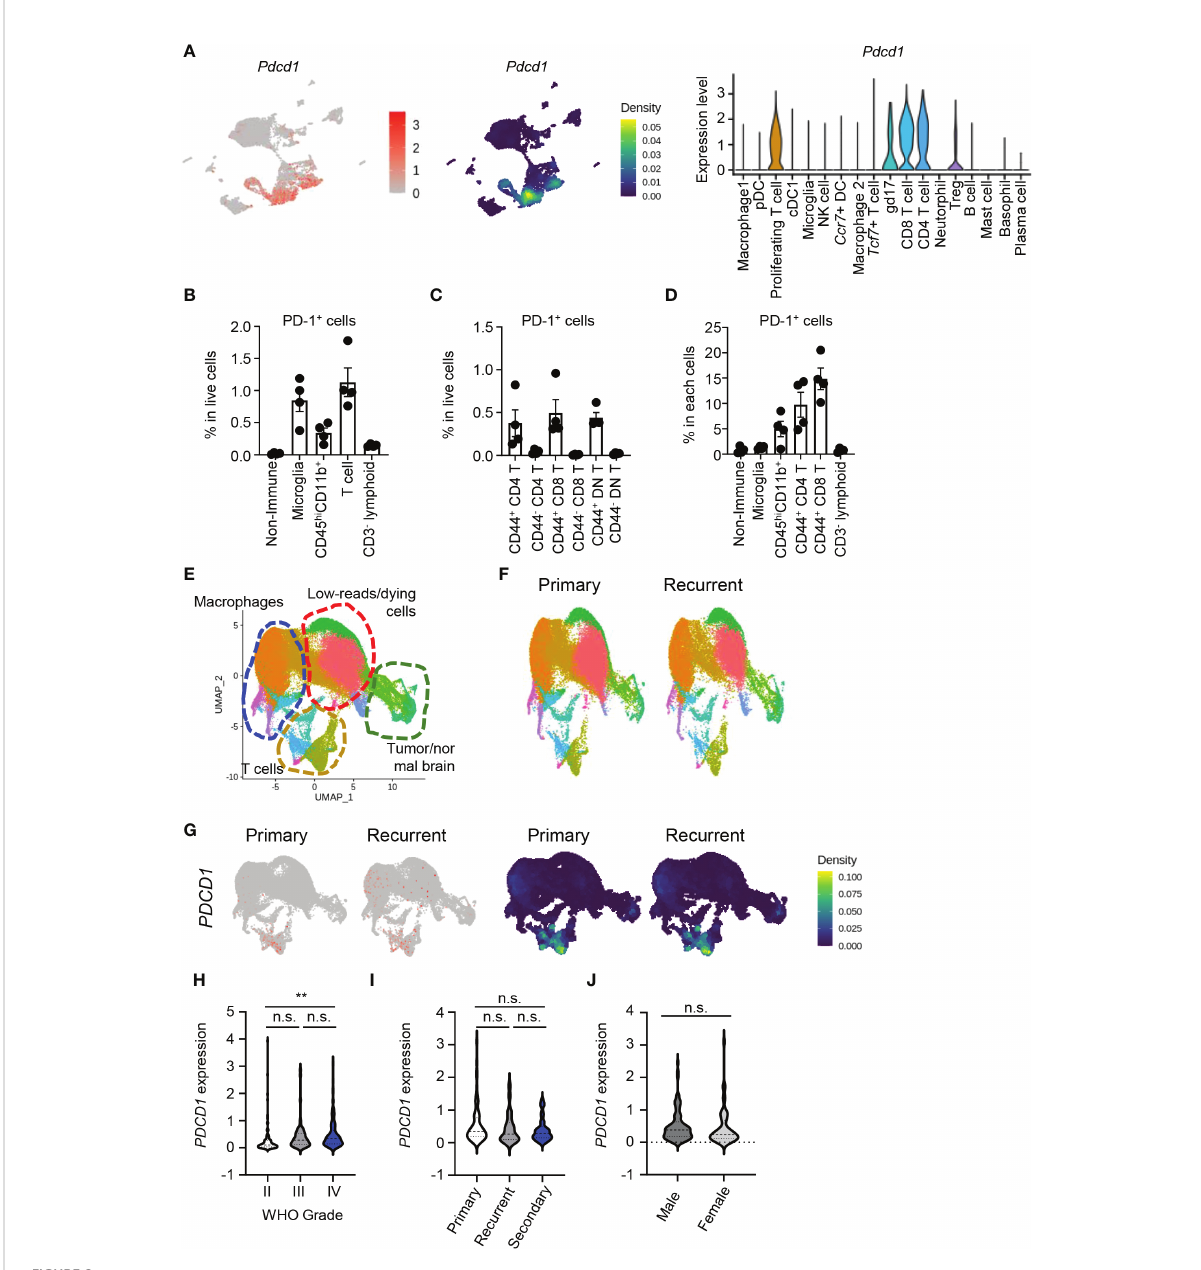
FIGURE 2 PD-1 is dominantly expressed by CD8 T cells in brain tumor tissues. (A) Using scRNAseq data, expression of Pdcd1 was visualized by FeaturePlot, density plot, and VlnPlot. (B – D) Eight-week-old C57BL/6J mice were intracranially injected with GL261 cells, and tumor tissues were analyzed by fl ow cytometry 10 days later. PD-1 + cells among total cells (B) , PD-1 + T cells among total cells (C) , and PD-1 + percent from each cell (D) were calculated. (E – G) Using the GSE154795 dataset, patients with primary (p) and recurrent (r) GBM were analyzed. (E) Macrophages, low- reads/dying cells, T cells, and tumor/normal brain cells were identi fi ed using markers. (F) UMAPs were compared between groups. (G) PDCD1 expression was compared between groups by FeaturePlot and density plot. (H – J) Using CGGA data, PDCD1 expression in patients divided by WHO grade (H) , subset of tumor (I) , and gender (J) were analyzed. Data in (H – J) were analyzed by unpaired, two-tailed Student ’ s t test. * P <0.05, ** P <0.01. Error bars represent the mean ± standard error of the mean (SEM). n.s., not signi fi